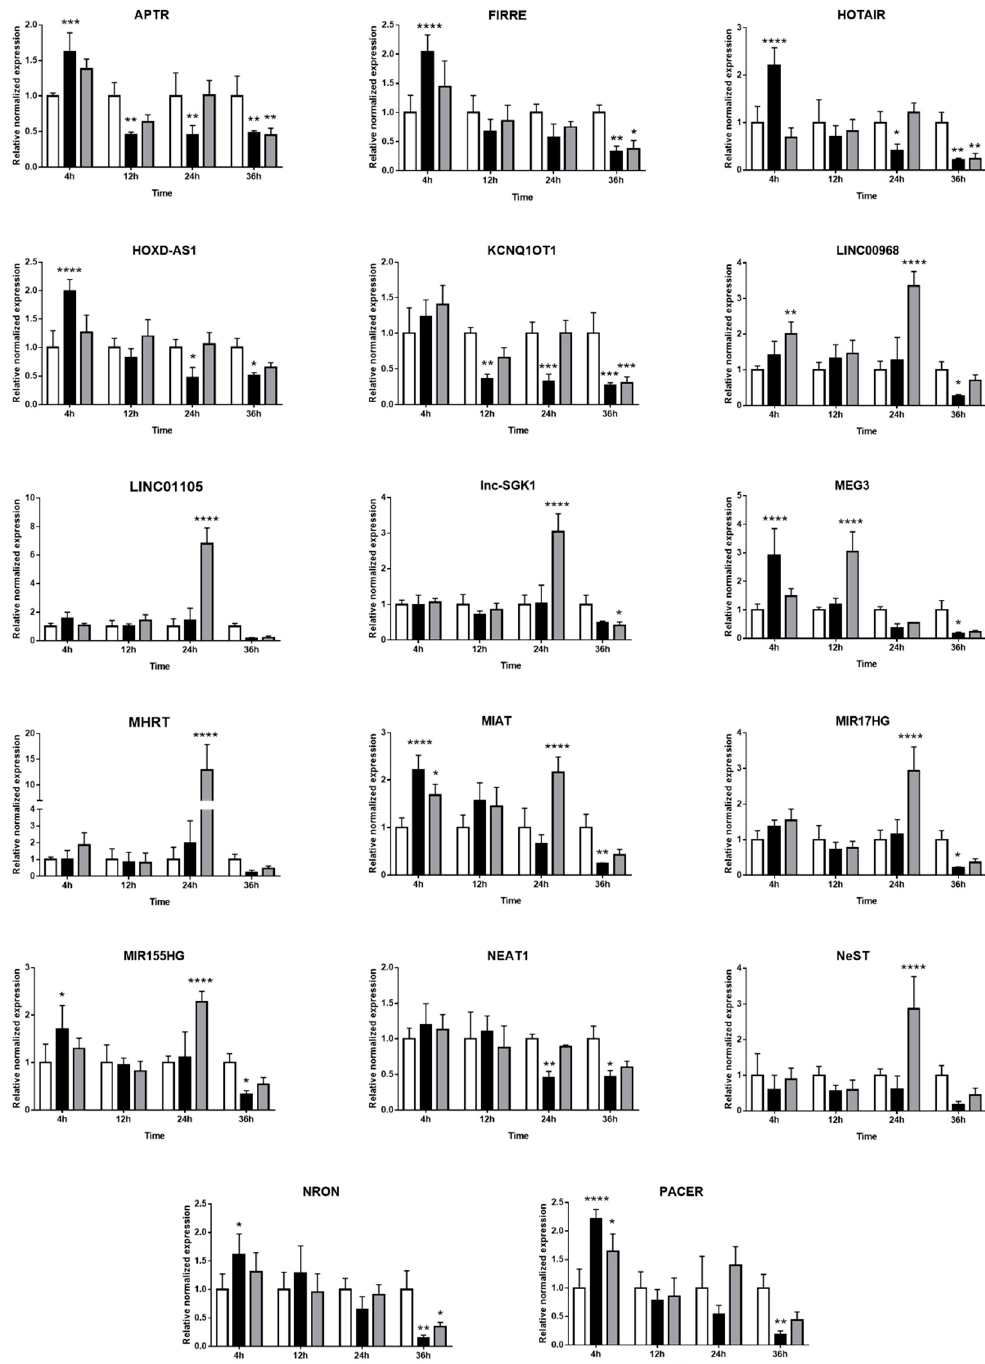
Figure 4. Expression of long non-coding RNAs in human retinal Müller cells infected with T. gondii tachyzoites with differences in response to parasite strains. Graphs show normalized lncRNA expression in uninfected versus GT-1 and GPHT strain-infected MIO-M1 cells (multiplicity of infection = 5; evaluated time points post-infection = 4, 12, 24, and 36 h). Reference genes were ribosomal protein lateral stalk subunit P0 (RPLP0) and peptidylprolyl isomerase A (PPIA). Data were analyzed by two-way ANOVA with Bonferroni post-test. n = 3 cultures / condition. Bars represent mean normalized expression, and error bars indicate standard deviation. White columns represent uninfected, black columns represent GT1 strain-infected, and grey columns represent GPHT strain-infected. * p < 0.05, ** p < 0.01, *** p < 0.001, and **** p < 0.0001.